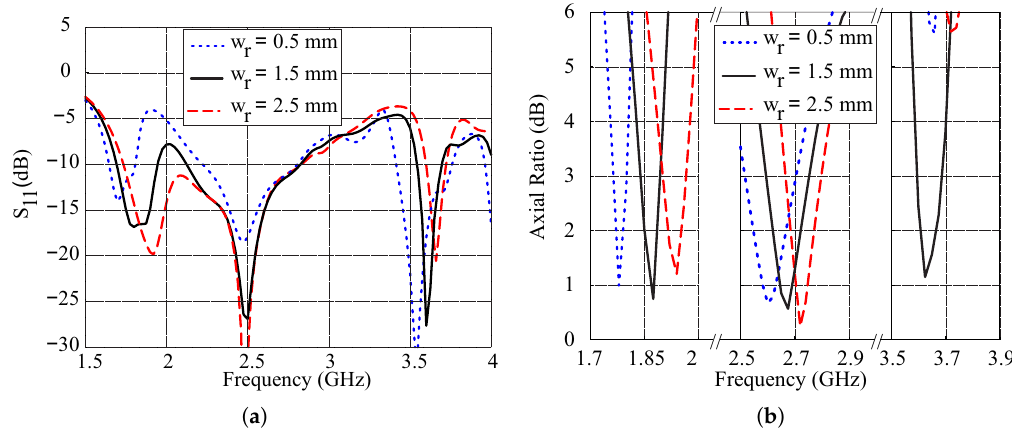
Figure 8. Simulated effects of variations in length w r of the SMR: ( a ) Reflection coefficients; ( b ) Axial